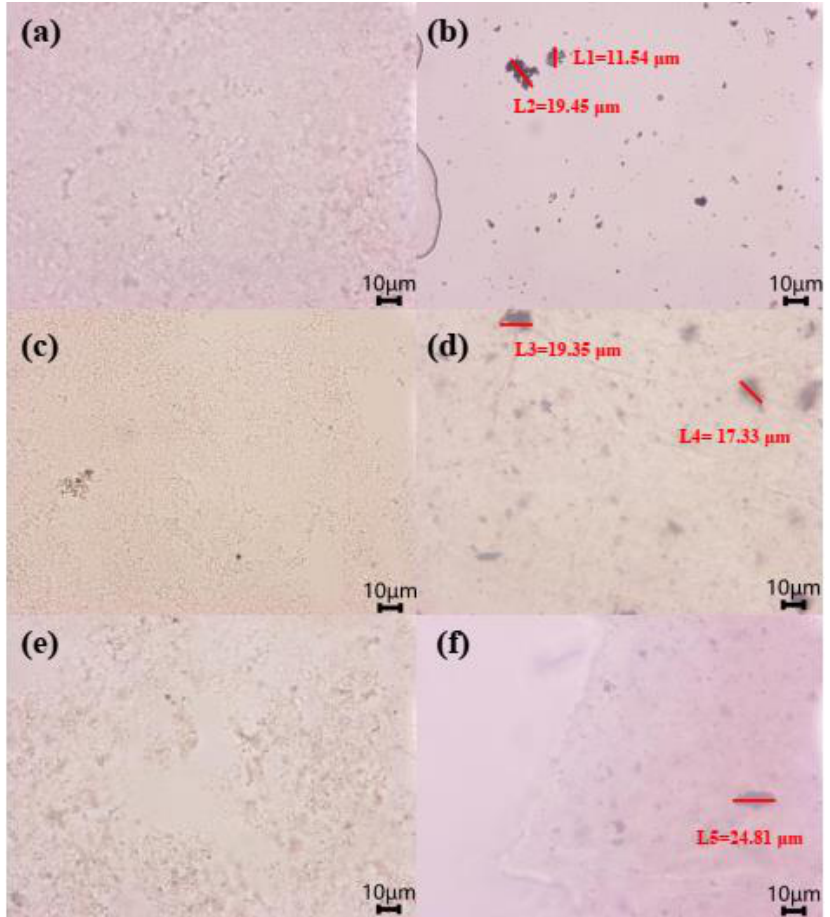
Figure 3. Silica scale particle size after 20 min ( b ), 30 min ( d ) and 40 min ( f ) electrocoagulation and corresponding blank control group ( a , c , e ).